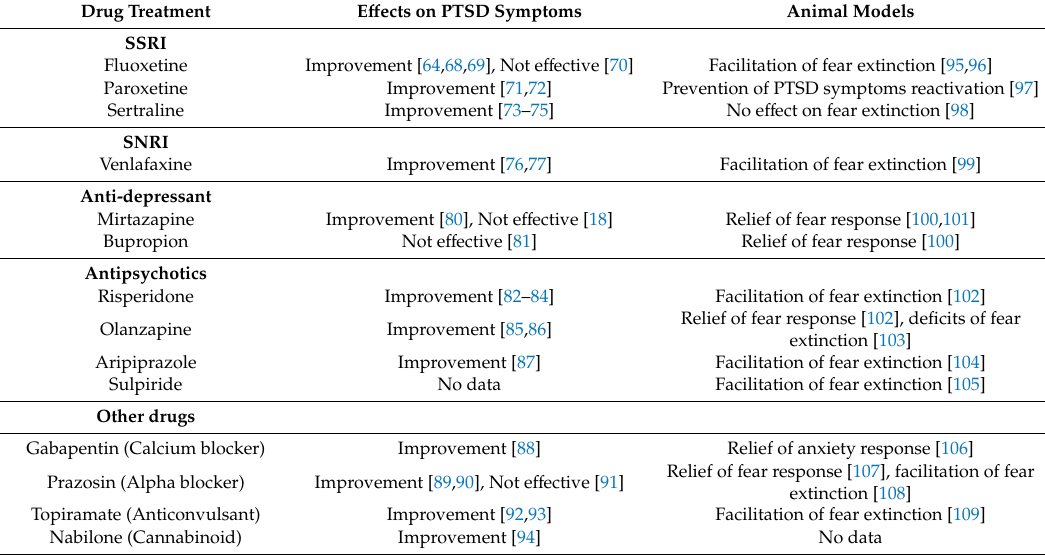
Table 1. E ff ects of clinical drugs in patients with post-traumatic stress disorder (PTSD) and animal models of